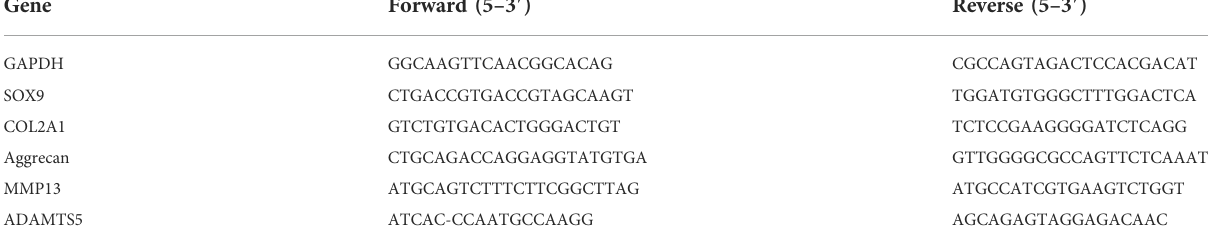
TABLE 1 Primers used in the qRT-PCR